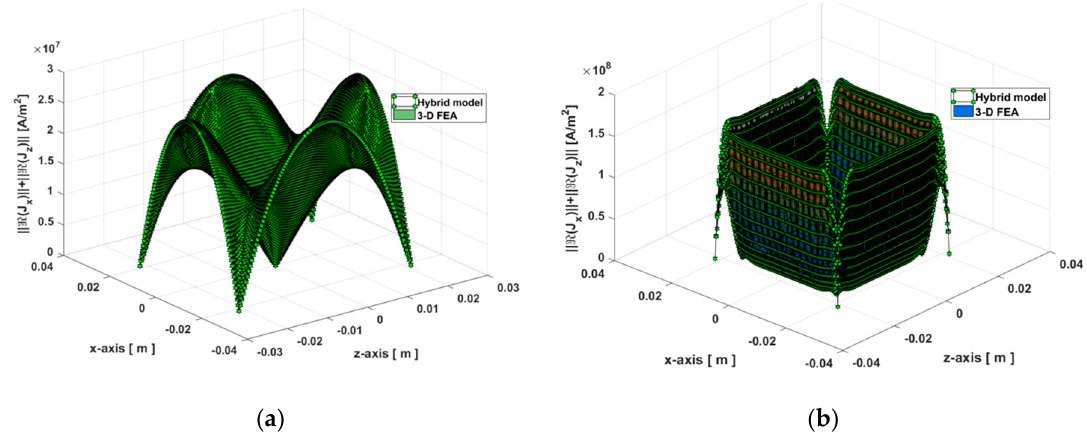
Figure 15. Evolution of J in the massive conductive part with I max = 7.78 A at t = 0 s and h mp = 6mm for: ( a ) f = 50Hz, and ( b ) f =